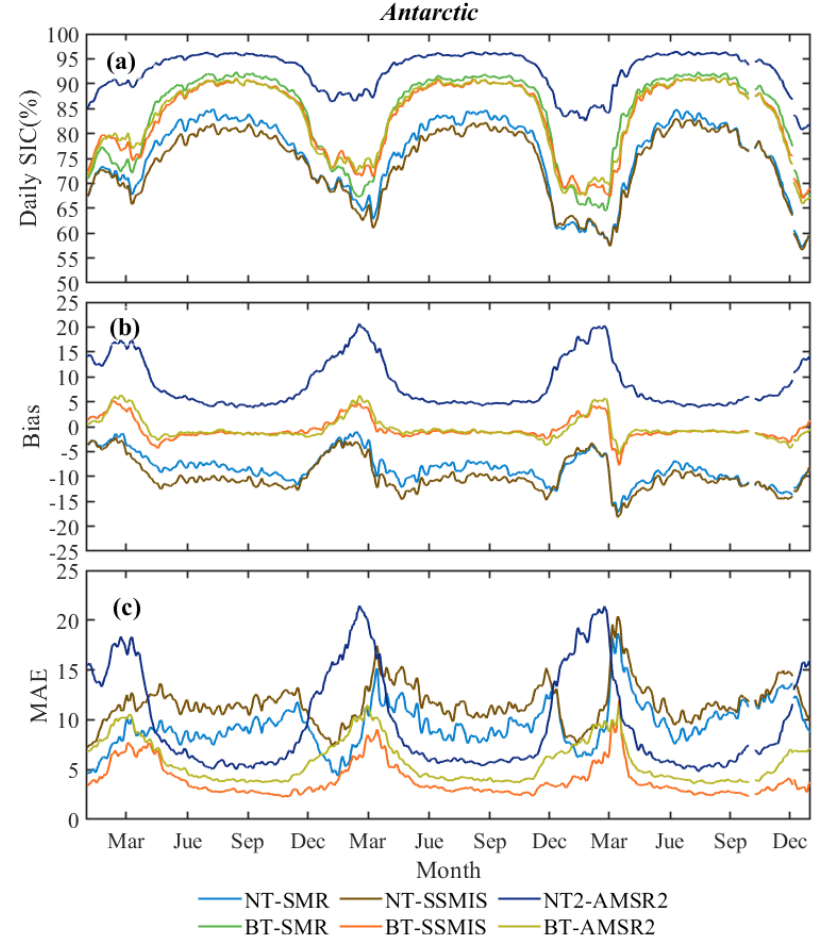
Figure 9. Same as in Figure 7 but in the Antarctic.